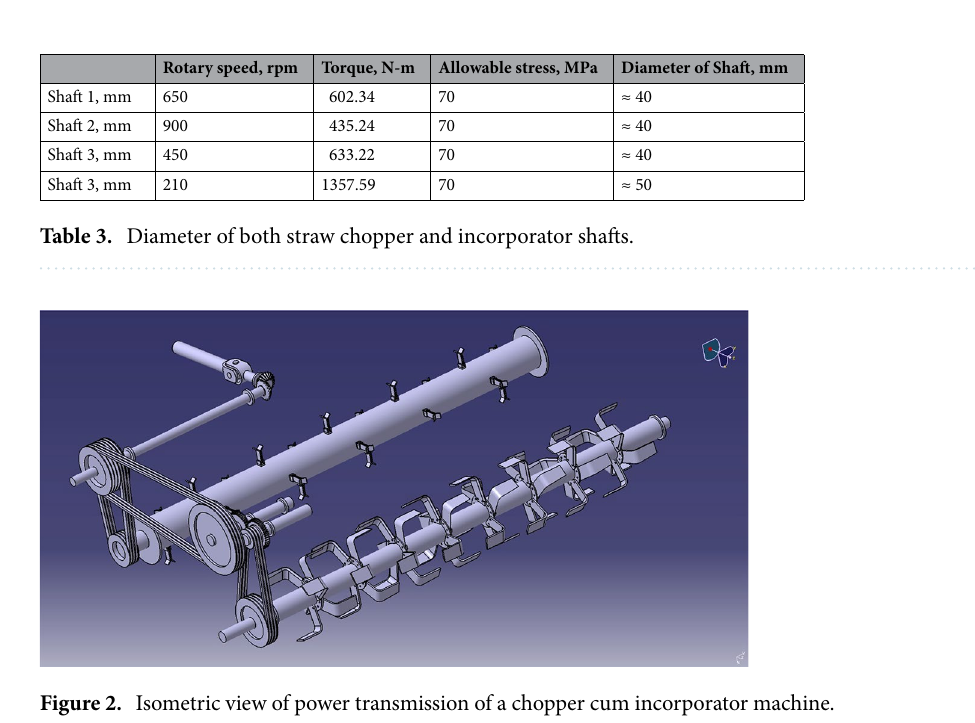
Figure 2. Isometric view of power transmission of a chopper cum incorporator